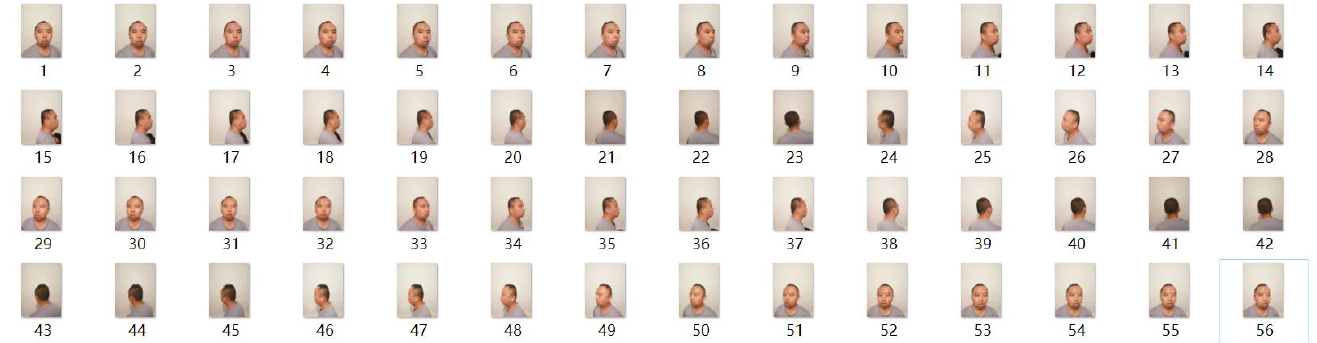
Figure 2. Photogrammetry image.